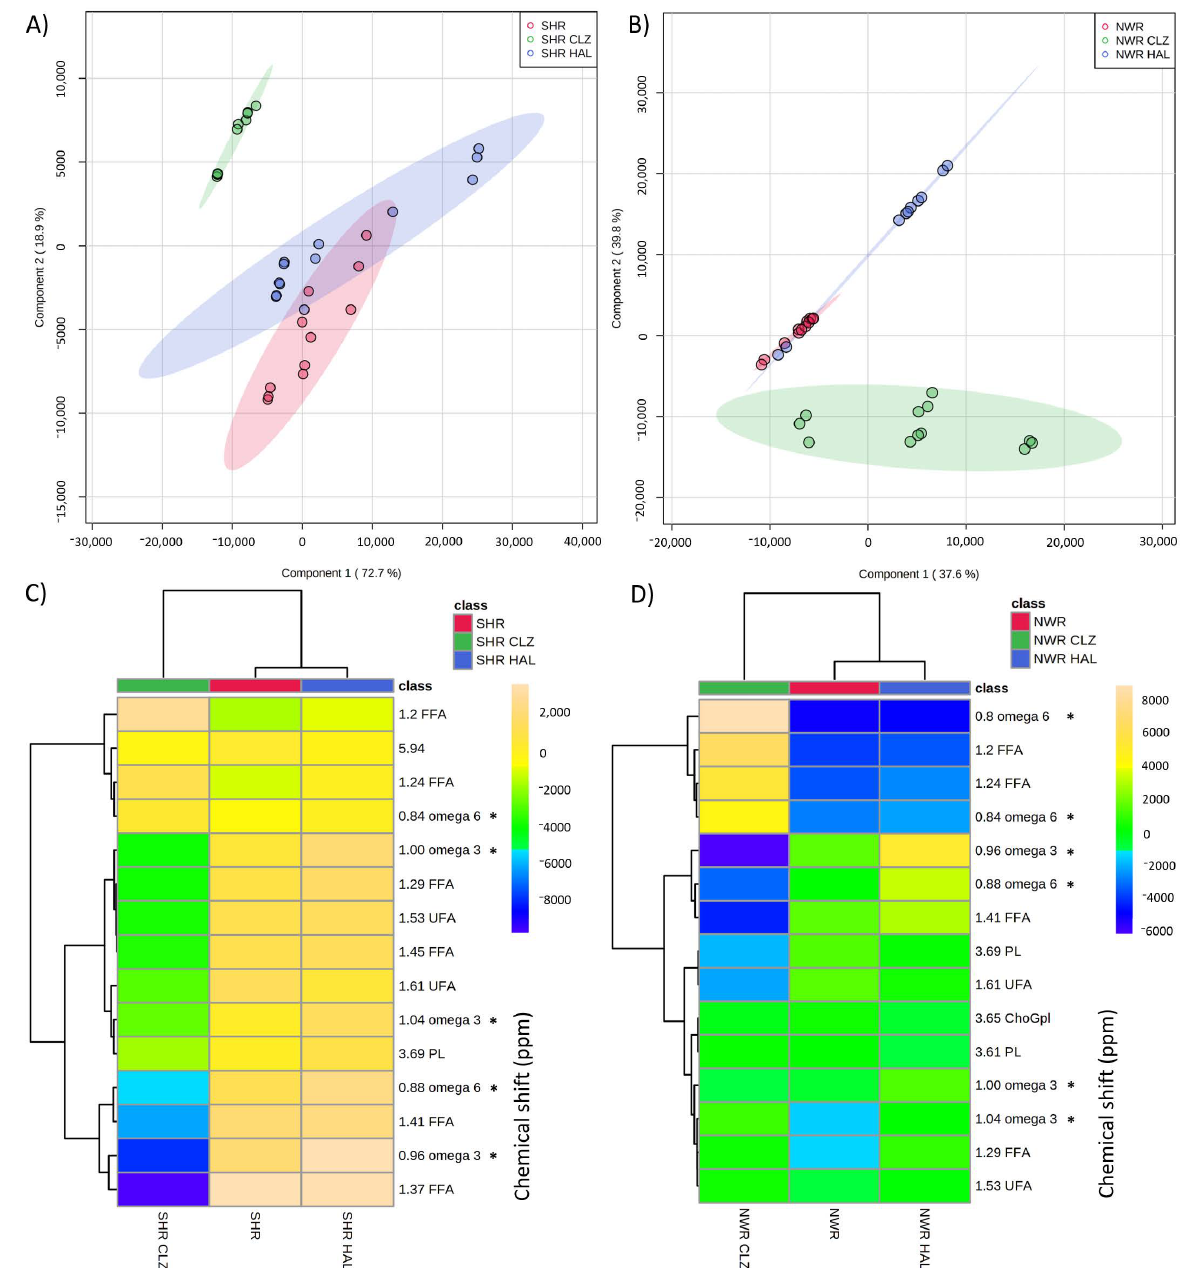
Figure 2. PLS-DA charts obtained for 1 H-NMR of lipids isolated from drug-naïve SHR ( A , C ) and drug-naïve NWR animals ( B , D ) after the treatment with typical haloperidol (HAL) or atypical clozapine (CLZ) antipsychotic drugs. SHR lipid profile changes are shown as PLS-DA scores ( A ) or heatmap ( C ) with the relative concentrations of the 15 best-ranked chemical shifts (VIP scores). NWR lipid profile changes are shown as PLS-DA scores ( B ) or heatmap ( D ) with the relative concentrations of the 15 best-ranked chemical shifts (VIP scores). A total of 34 spectra were used for PLS-DA analysis of SHR after treatment with typical HAL or atypical CLZ antipsychotic drugs, with five samples for each treatment (4 samples for SHR), performed in triplicate, but excluding one outlier of SHR, five outliers of SHR CLZ, and two outliers of SHR-HAL. A total of 34 spectra were used for PLS-DA analysis of NWR treated with typical HAL or atypical CLZ antipsychotic drugs, with five samples for each treatment (four samples for NWR), performed in triplicate, but excluding two outliers of NWR-CLZ, and five outliers of NWR-HAL. In ( C , D ), chemical shifts marked for omega 3 *, omega 6 *, may come from other unsaturated acyl groups. PL: phospholipids, ChoGpl: choline glycerophospholipids, chol: cholesterol, FFA: free fatty acids, PUFA: polyunsaturated fatty acids, UFA: unsaturated fatty